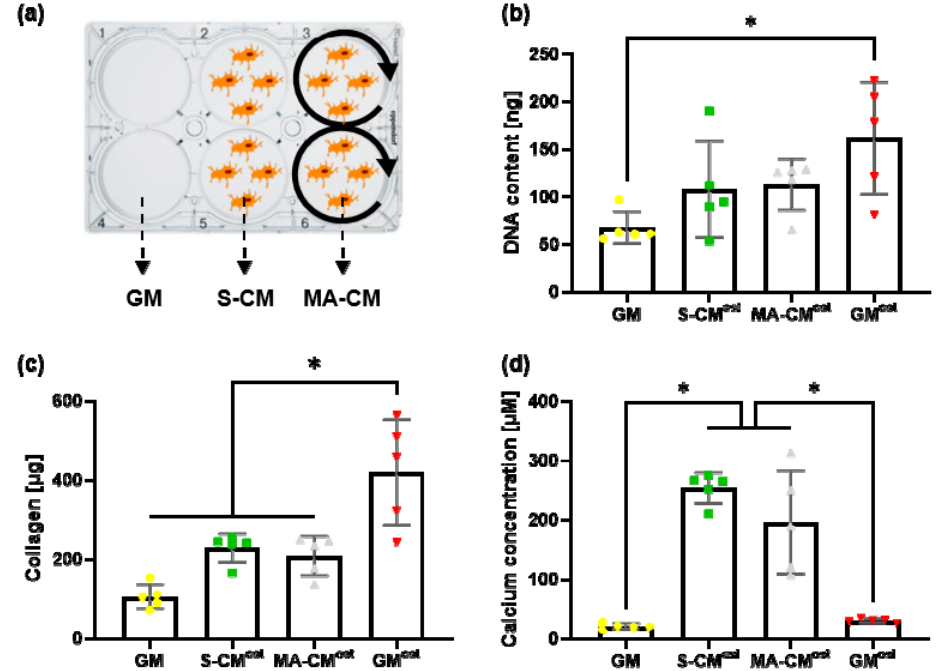
Figure 3. Effect of paracrine factors released by osteocytes on hMSC behavior in 2D cell culture. ( a ) Overview of the different media groups including growth medium (GM), conditioned medium collected from statically cultured osteocytes (S-CM) and conditioned medium collected from mechanically activated osteocytes (MA-CM); ( b ) quantification of the DNA content through a picogreen dsDNA kit for hMSCs treated with GM, S-CM ost , MA-CM ost , and the growth medium group supplemented with osteogenic factors (GM ost ) (n = 5); ( c ) quantification of collagen deposition through the amount of bound picrosirius red staining for each medium group (n = 5); ( d ) quantification of mineral deposition through the amount of bound alizarin red staining for every medium group (n = 5).